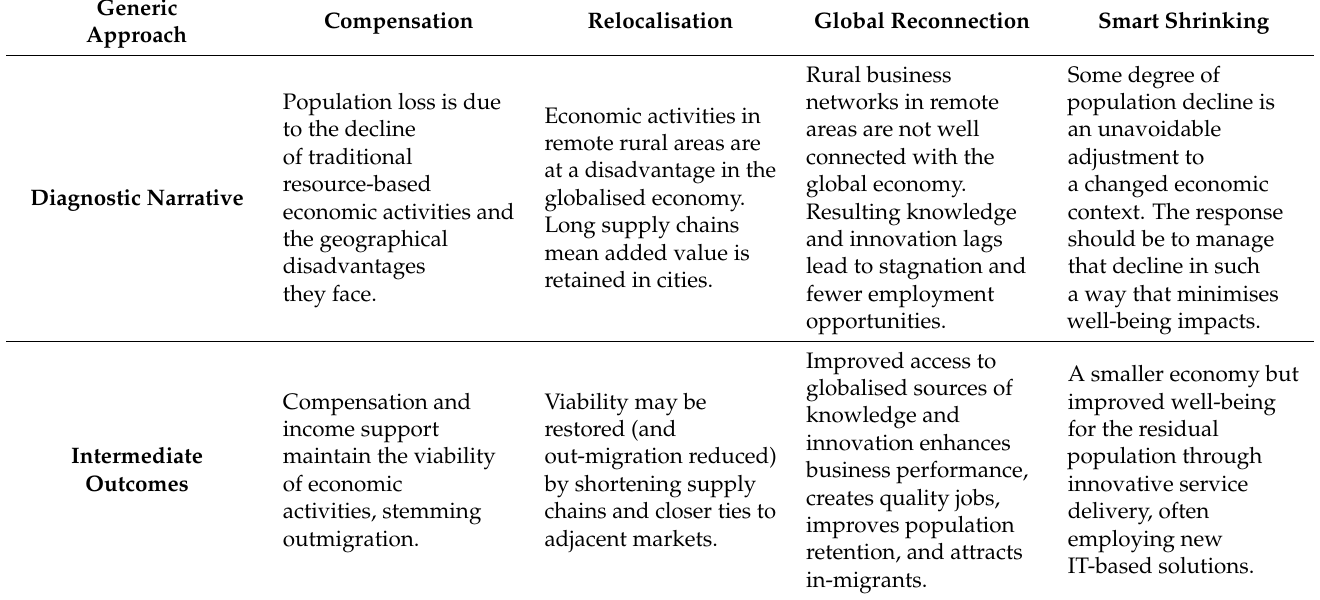
Table 1. Key ToC Features of Four Generic Policy Approaches to Rural Shrinking